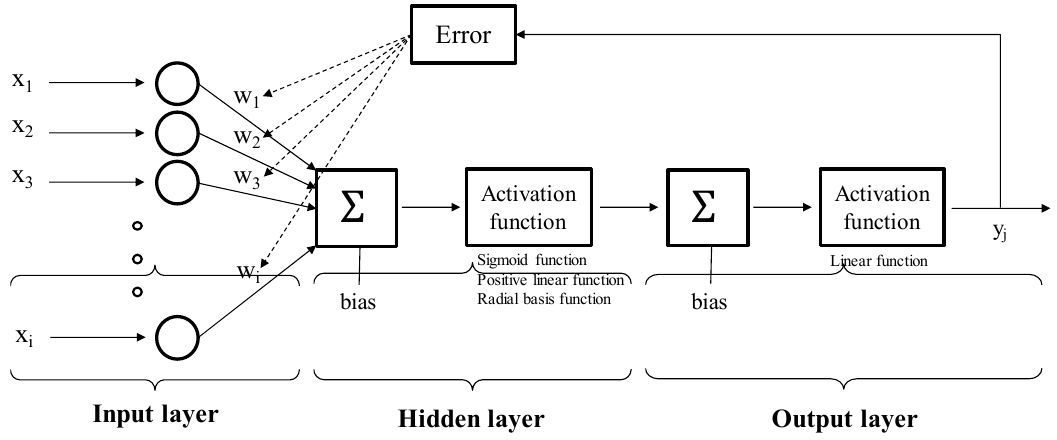
Figure 1. Schematic diagram for artificial neural network [21].